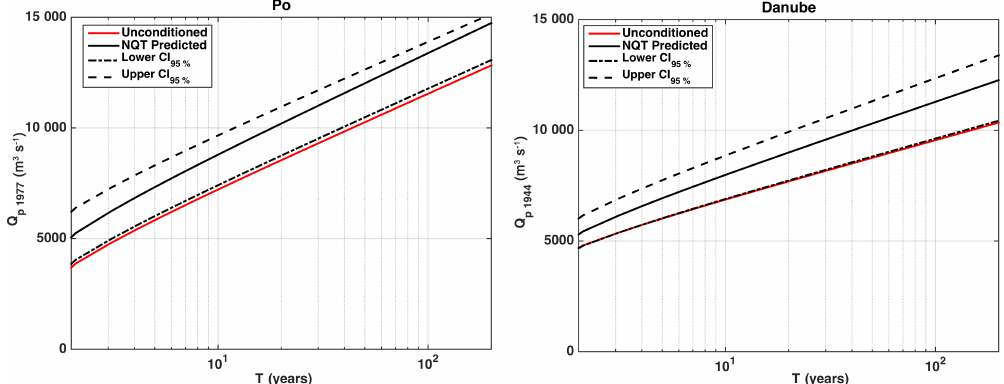
Figure 8. Leave-one-out cross validation. Unconditioned EV1 probability distribution of peak flows for the year with the wettest pre-flood season (1977 in the Po, 1944 in the upper Danube) along with conditioned distributions with related 95% confidence